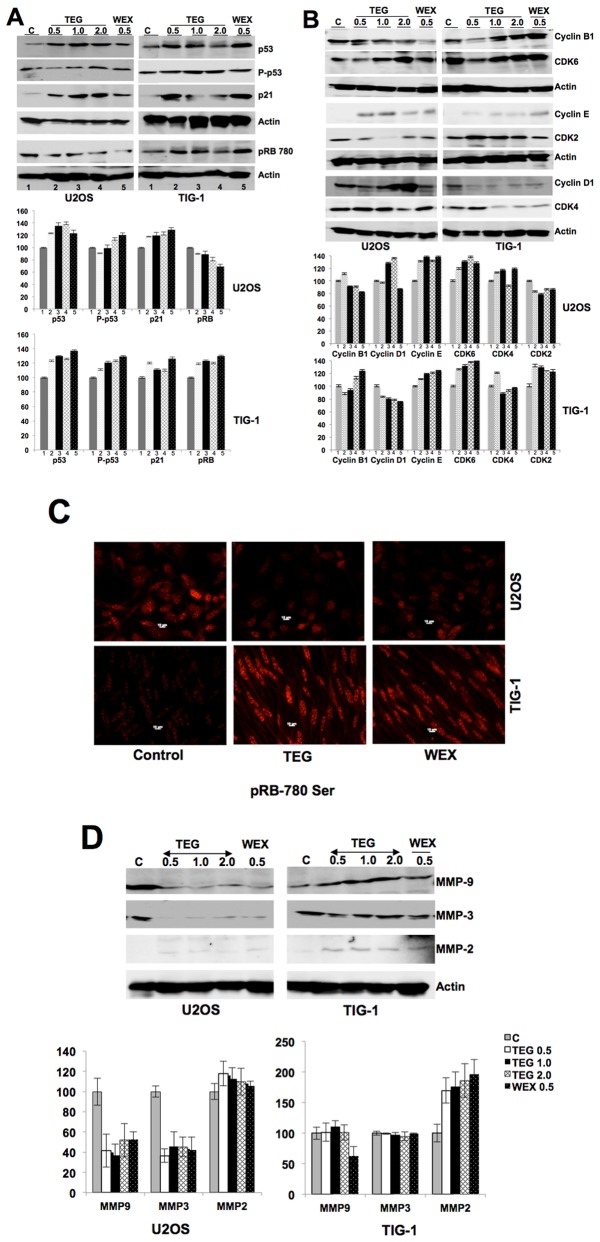
Molecular analyses of the cancer cell specific cytotoxicity and anti-migration activity in WEX (ASH-WEX) and TEG.(A) Western analysis of U2OS and TIG-1 cells for indicated proteins. Increase in p53 and p21 was observed both in cancer and normal cells. Whereas phosphorylated RB decreased in cancer cells, it increased in normal cells. Quantitation of the signals from three independent experiments is shown in the lower panel. (B) Changes in the level of cyclins (B1, D1 and E), CDK2, CDK4 and CDK6 are shown. Whereas cyclin D1 showed accumulation in cancer cells in response to TEG and WEX treatment; it was decreased in normal cells when treated in parallel. Quantitation of the signals from three independent experiments is shown in the lower panel. (C) Phosphorylation of RB as examined by immunostaining is shown. Whereas cancer cells showed decrease in phosphorylated RB, normal cells showed its increase. (D) WEX and TEG treated cancer cells, but not the normal cells, showed sharp decrease in MMP-9 and MMP-3. Quantitation of the signals from three independent experiments is shown in the lower panel.